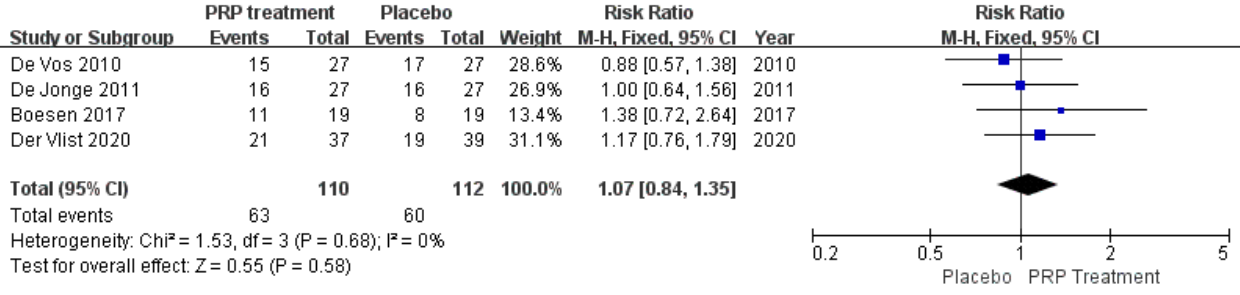
Figure 8. Forest plot of changes in patient satisfaction.